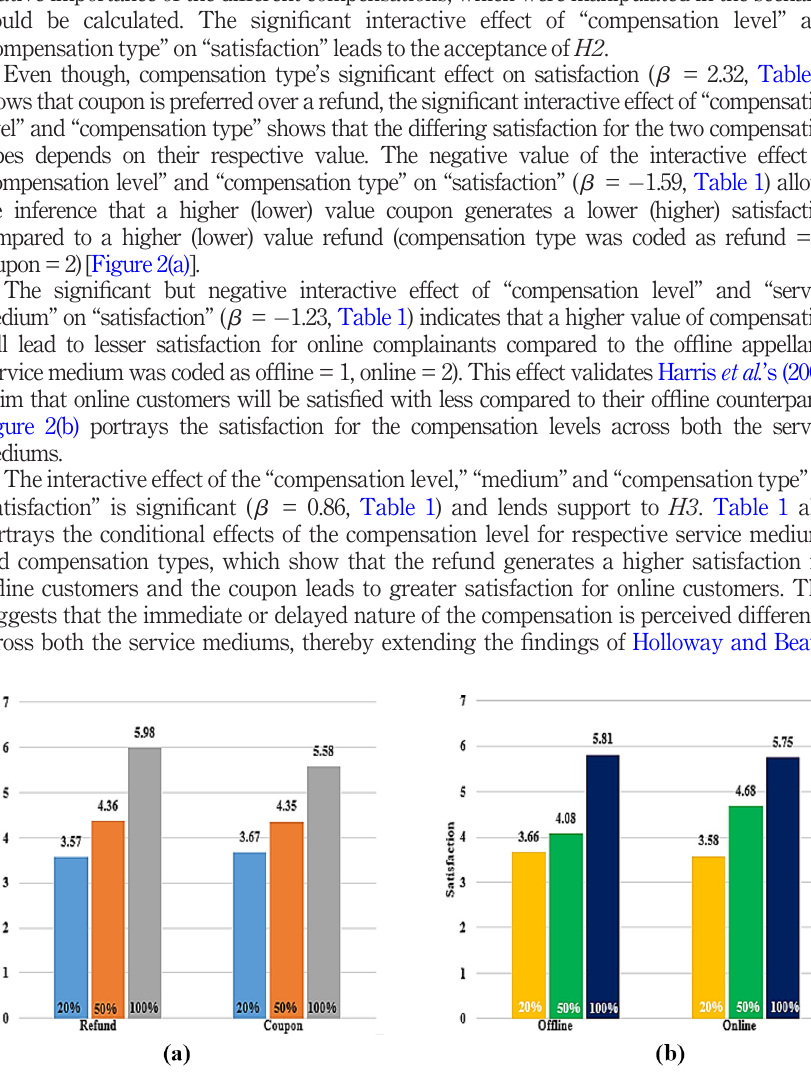
Figure 2. Satisfaction